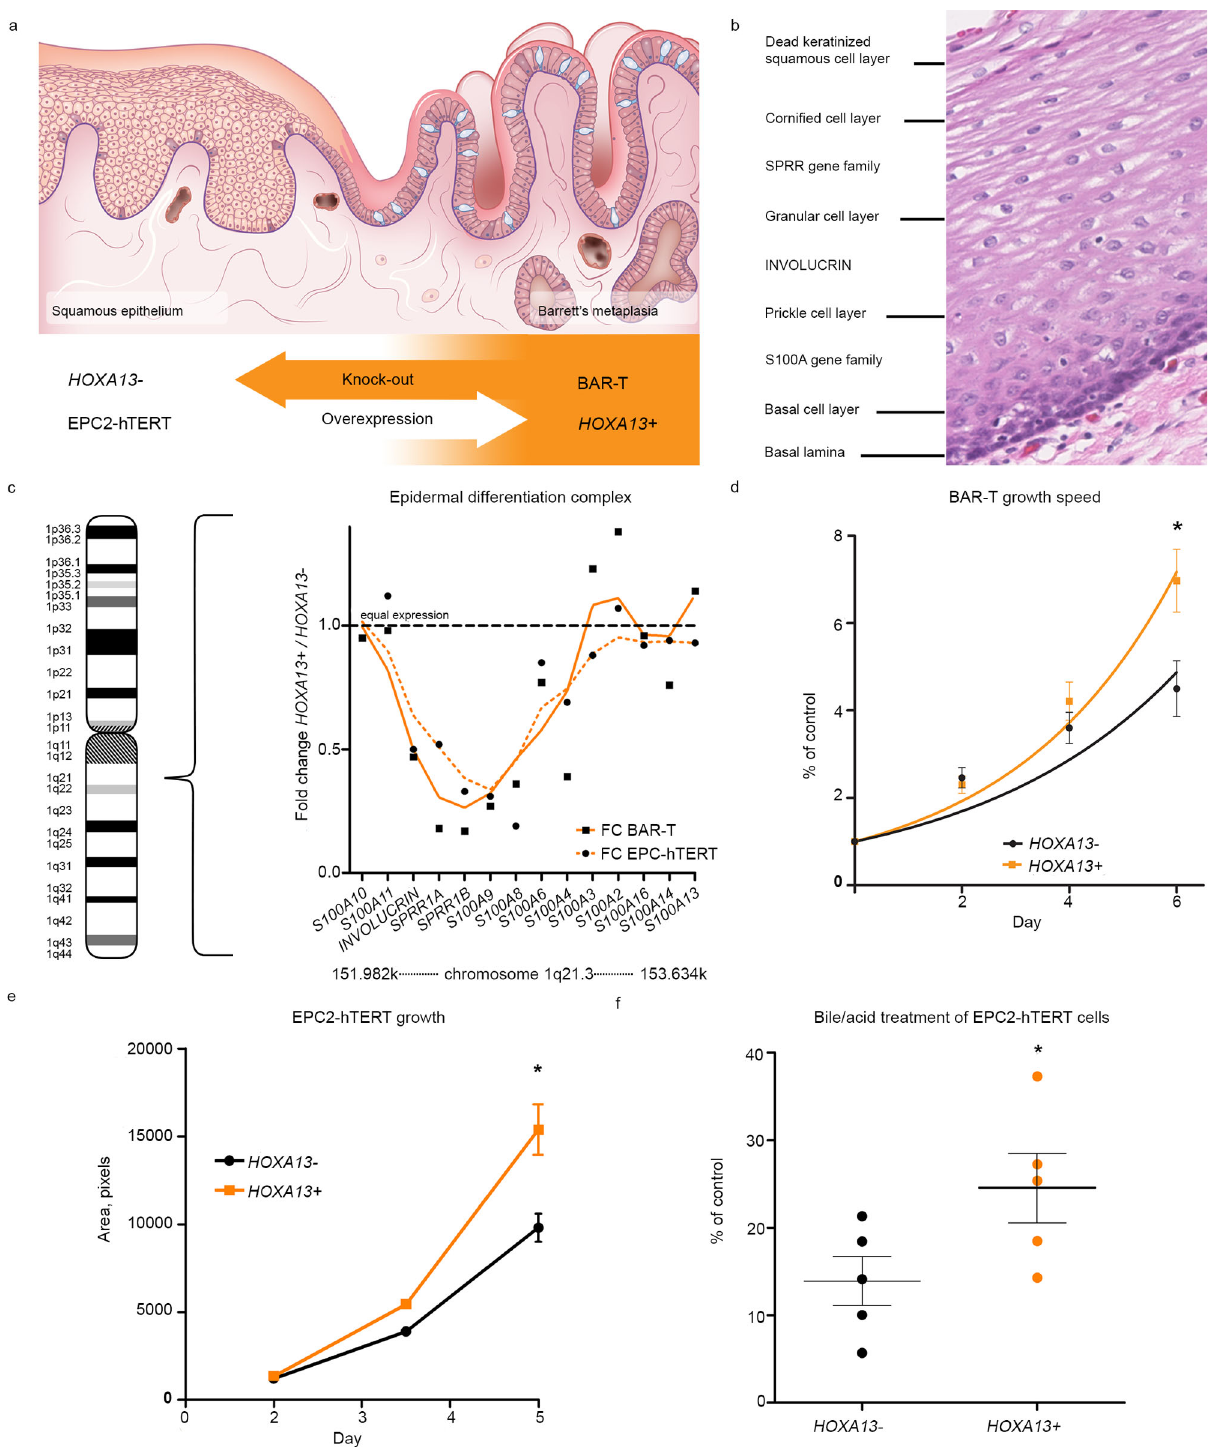
We further investigated the morphological role of HOXA13 in the BE-derived BAR-T cell line. In 2D cultures, an altered spatial distribution in growth pattern was observed, with cells growing more closely together in the absence of HOXA13 suggesting an effect on tissue morphology (Fig. 7c). The BAR-T cell model also allows testing the effect of HOXA13 on columnar versus squamous differentiation in in vitro and in vivo settings. A 3D in vivo tissue reconstitution model was employed in which BAR- T cells were grafted in the lumina of devitalized and denuded